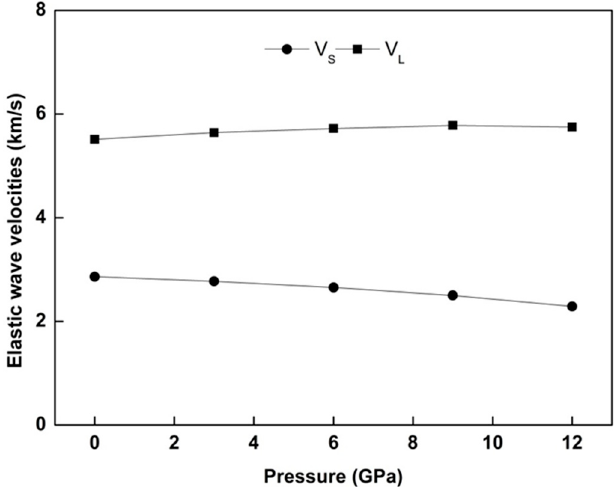
Figure 5. Behavior of longitudinal (V L ) and shear wave (V S ) velocities of WZ ZnS under pressure.